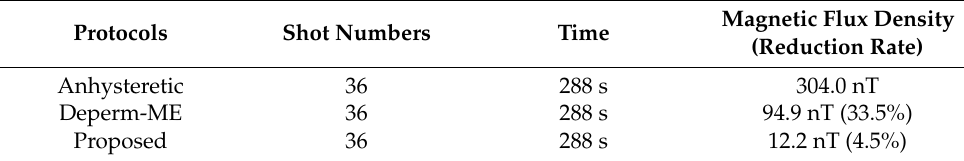
Figure 13. Experimental results of the SPCC following the deperming protocols. Table 1. Measured magnetic flux density of the SPCC following the protocols.